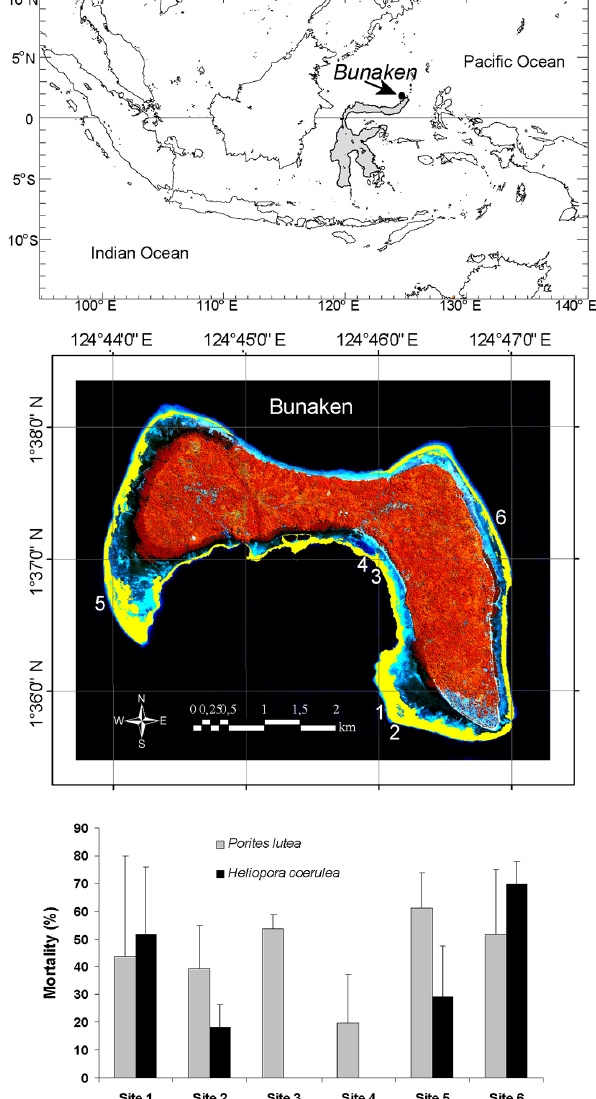
Figure 2. Top: Bunaken location in the north of Sulawesi, the large island in grey. Middle: Close-up of the island of Bunaken. The yel- low area shows where coral mortality occurred around Bunaken reef flats, with the position of six sampling stations. Dark areas between the yellow mask and the land are seagrass beds. Blue-cyan areas are slopes and reef flats without mortality. Bottom: Mortality rates for the six sites for two dominant species Porites lutea and Heliopora coerulea . The latter is not found on Sites 3 and 4. The number of colonies ranged between 10 and 30 per transect, depending on the size of the